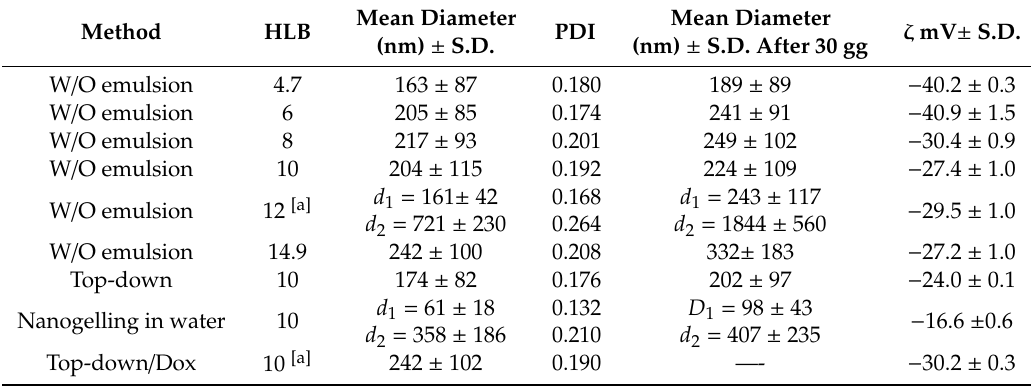
Figure 2. Chemical formulas of components used for the peptide-based nanogel formulation. Internal core (red) is formed by Fmoc-Phe-Phe-OH (Fmoc-FF). External surfactants shell (green) was formulated using d- α -tocopherol polyethylene glycol 1000 succinate (E-TPGS-PEG1000) or mixing SPAN ® 60 (sorbitan monostearate) and TWEEN ® 60 (polyethylene glycol sorbitan monostearate) in different ratios. Table 1. Structural characterization (mean diameter, polydispersity index (PDI), and zeta potential) of Fmoc-FF nanogels prepared according to the three methods.